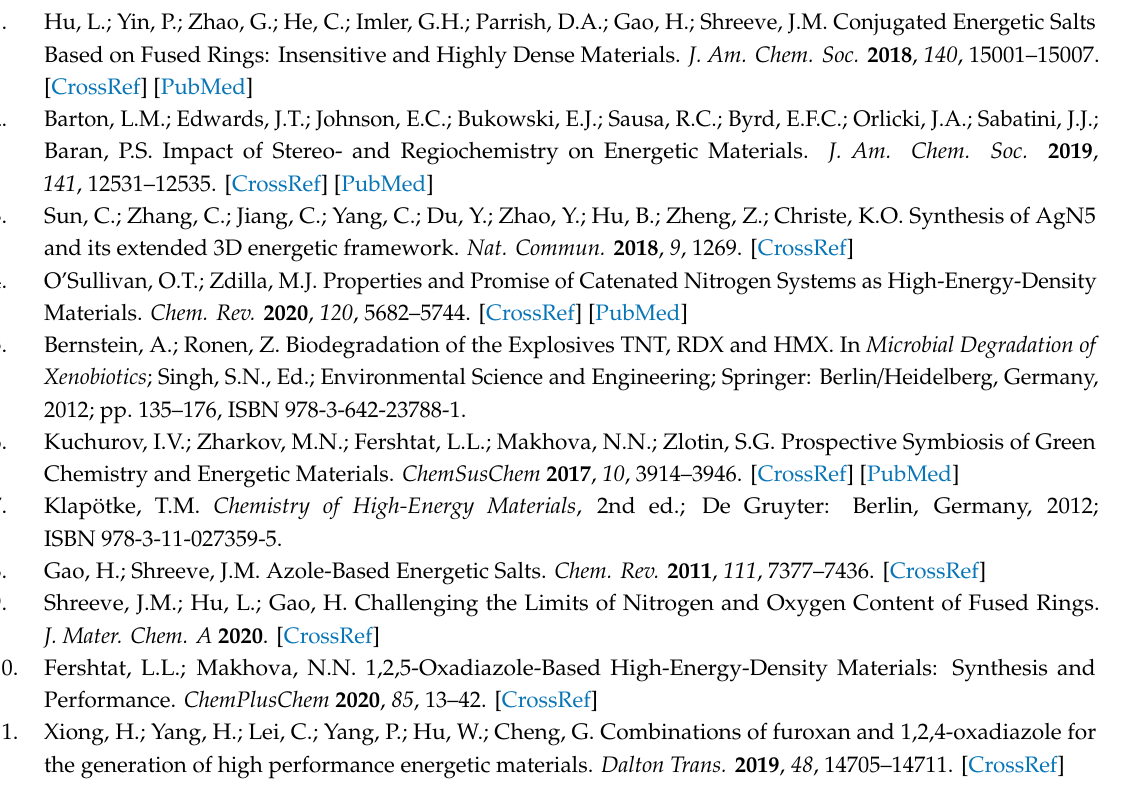
Supplementary Materials: The following are available online. Table S1: Crystal data and structure refinement for 12 , Table S2: Atomic coordinates and equivalent isotropic displacement parameters for 12 , Table S3: Bond lengths [Å] and angles [ ◦ ] for 12 , Table S4: Anisotropic displacement parameters for 12 , Table S5: Torsion angles [ ◦ ] for 12 . Figure S1: Thermal cycling of 1 : first heating up to melting, cooling with crystallization and reheating with a single endothermic event, Figure S2: The DSC curves of 1 and 2 at atmospheric pressure (solid curves) and under elevated nitrogen pressure of 2.0 MPa (dashed curves) at the heating rate at 5 K min − 1 . Figure S3: DSC traces for investigated furoxans 1–20 acquired at 5 K min-1 heating rate. The red curves correspond to the elevated pressure (2.0 MPa), the blue curves—to the atmospheric pressure. Table S6: A full set of the safety properties of the compounds